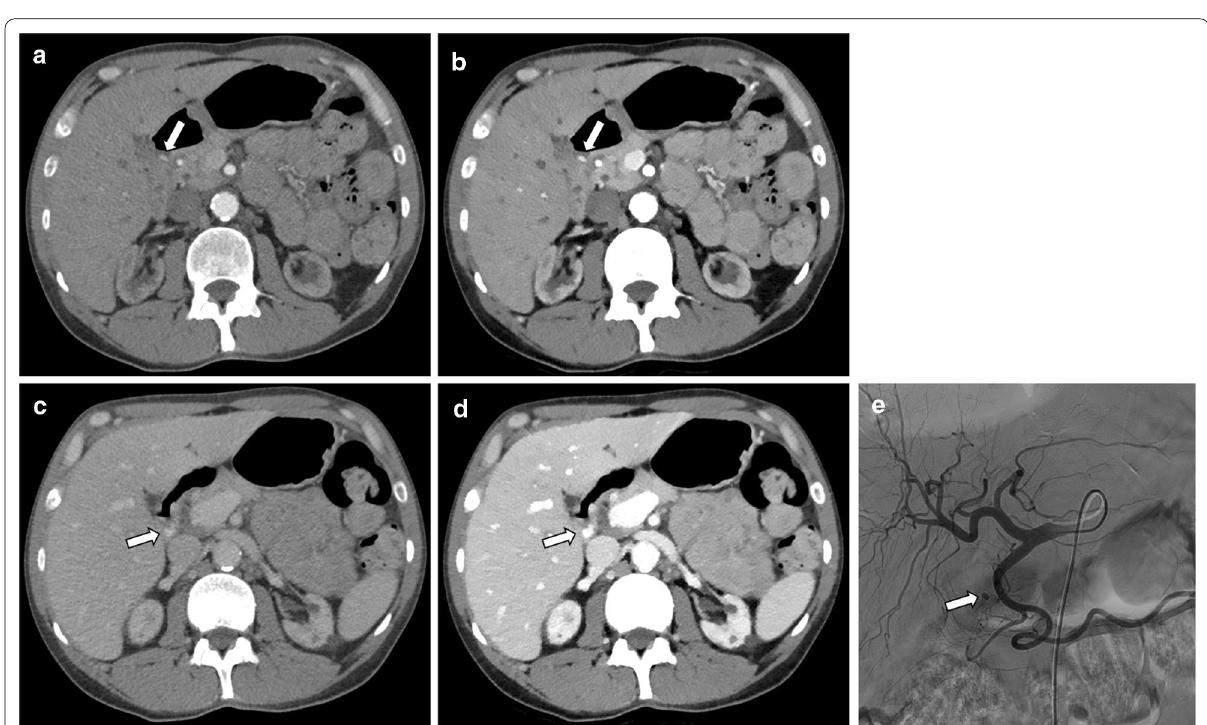
Fig. 10 A 40-year-old man with upper gastrointestinal bleeding who underwent multiphasic CT for localization. Conventional images show contrast extravasation in the duodenal bulb (arrows) on the arterial ( a ) and venous ( c ) phases. The extravasation is more conspicuous using 50 keV mono-energetic images on both the arterial ( b ) and venous ( d ) phases. The focus of active bleeding is proven on digital subtraction angiography ( e )